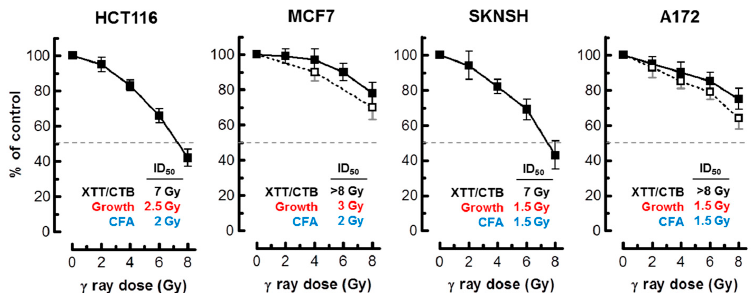
Figure 6. Radiosensitivity of the indicated cell lines evaluated by the 96-well plate XTT (solid squares) and CellTiter-Blue (open squares) assays. Bars, SE. The ID 50 values for colorimetric (this Figure), growth inhibition and colony formation (Figure 1) assays are shown. CTB, CellTiter-Blue; CFA, colony forming ability; ID 50 , inhibiting dose 50%.